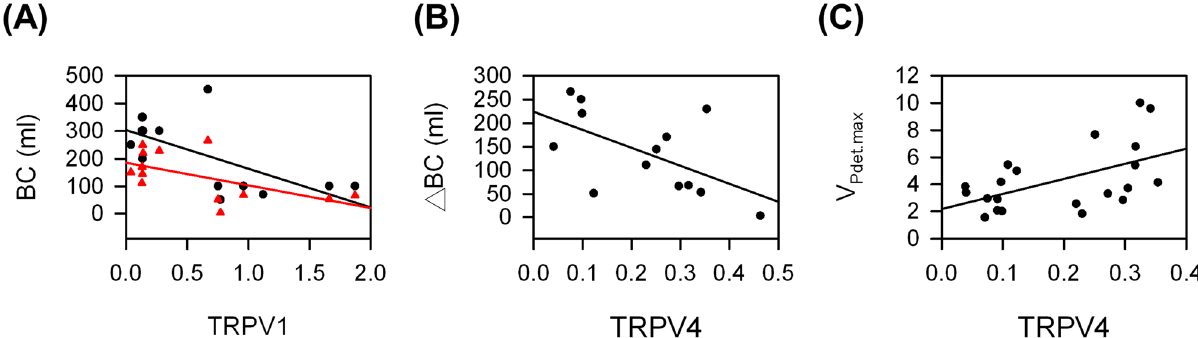
Figure 5. Significant associations between urodynamic parameters and the expression of TRPV1 or TRPV4 form KC patients: ( A ) between MBC (black circle) or ΔBC (red triangle) and TRPV1, ( B ) between ΔBC and TRPV4, and ( C ) between V Pdet.max and TRPV4.